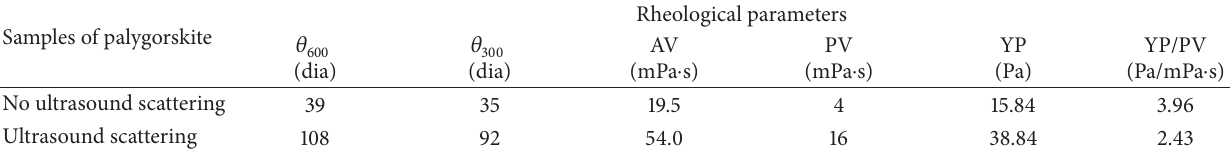
Table 3: The effect of ultrasound scattering on the rheological parameters of palygorskite suspension. Samples of